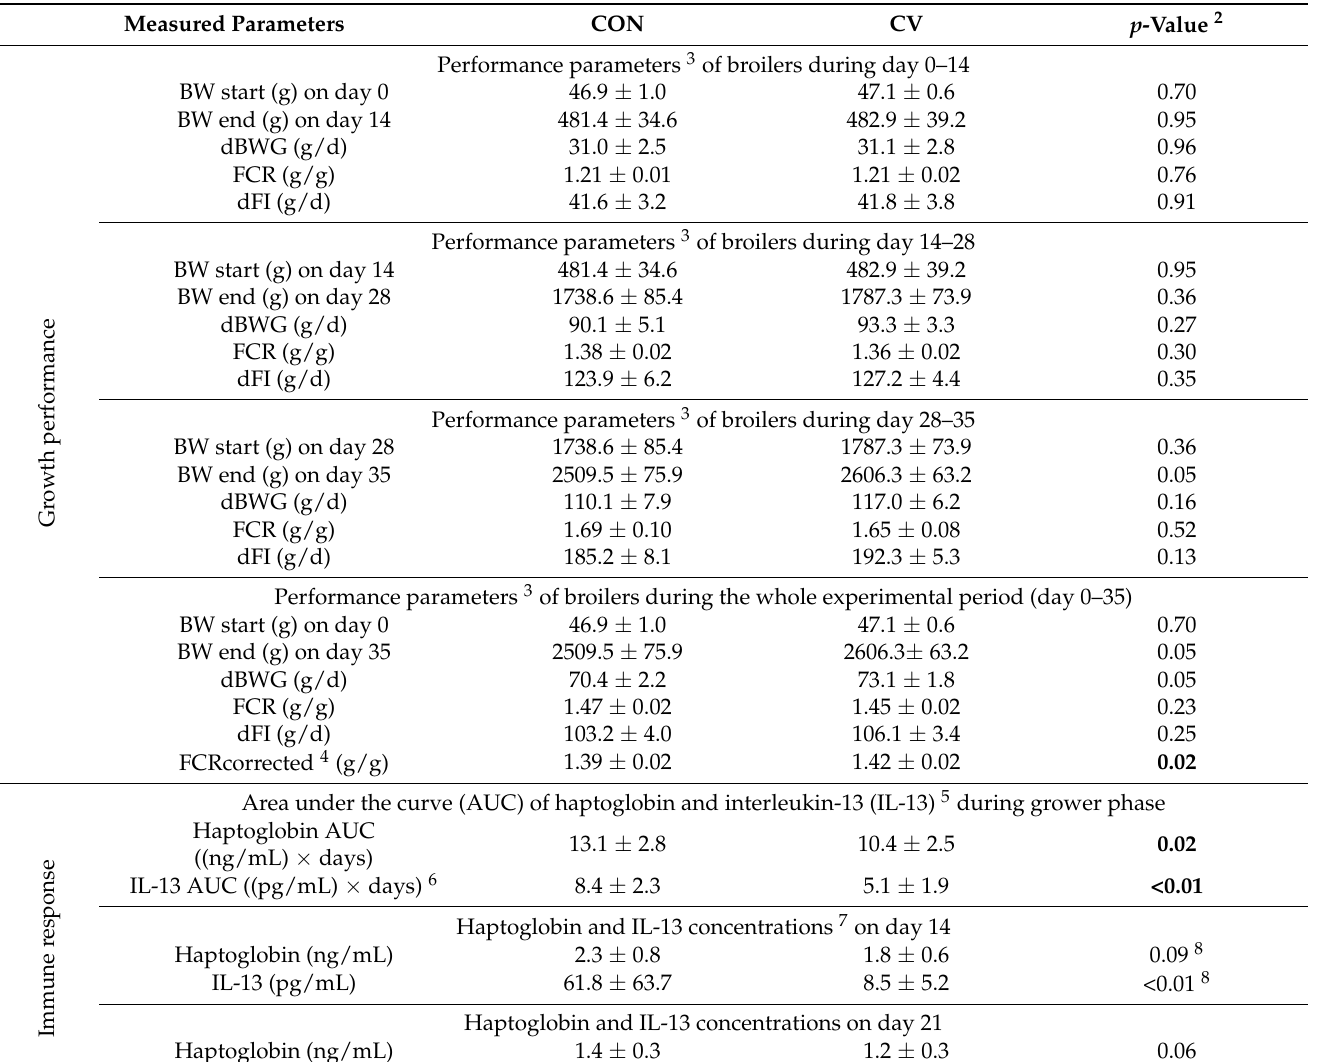
Table 1. Dietary effect of feeding either a control (CON) or Chlorella vulgaris (CV)-based diet 1 on growth performance, immune response, and intestinal morphology of broiler chickens. Measured Parameters CON CV p -Value 2 Performance parameters 3 of broilers during day